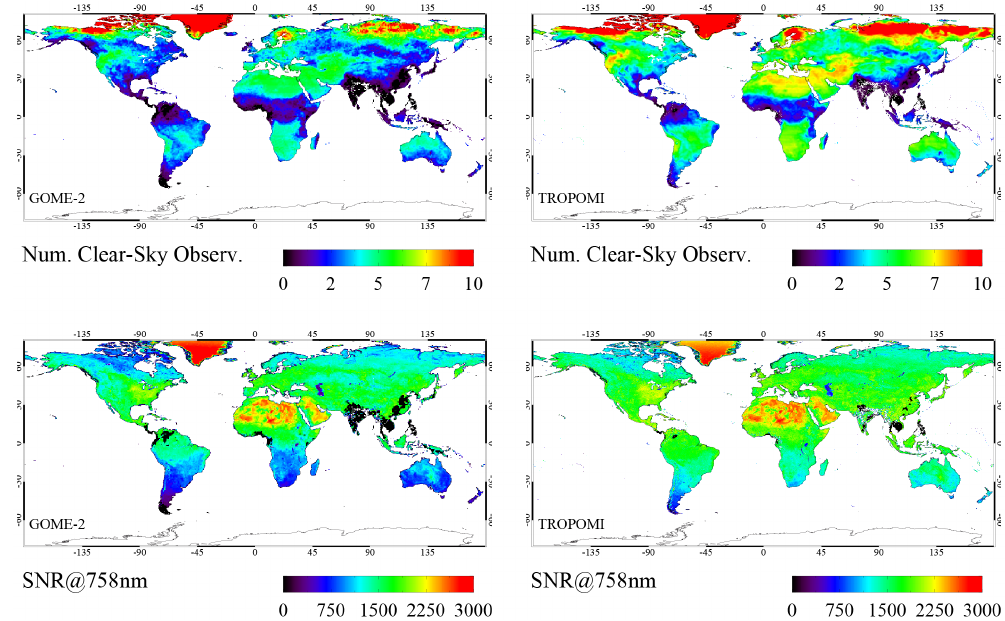
Figure 10. Global composites of total number of clear-sky observations and SNR at 758nm for GOME-2 (left column) and TROPOMI (right column). The simulations are for 7-day time averages in July. The overpass time and the gridbox size is 13h and 0.1 ◦ for TROPOMI and 9h and 0.5 ◦ for GOME-2. Input SNR–radiance curves are shown in Fig. 3. Cloud-free gridboxes are defined as those for which the fraction of cloudy pixel area is < 50%. Black gaps in the maps correspond to areas for which the number of clear-sky observations in the 7-day period is statistically < 1.